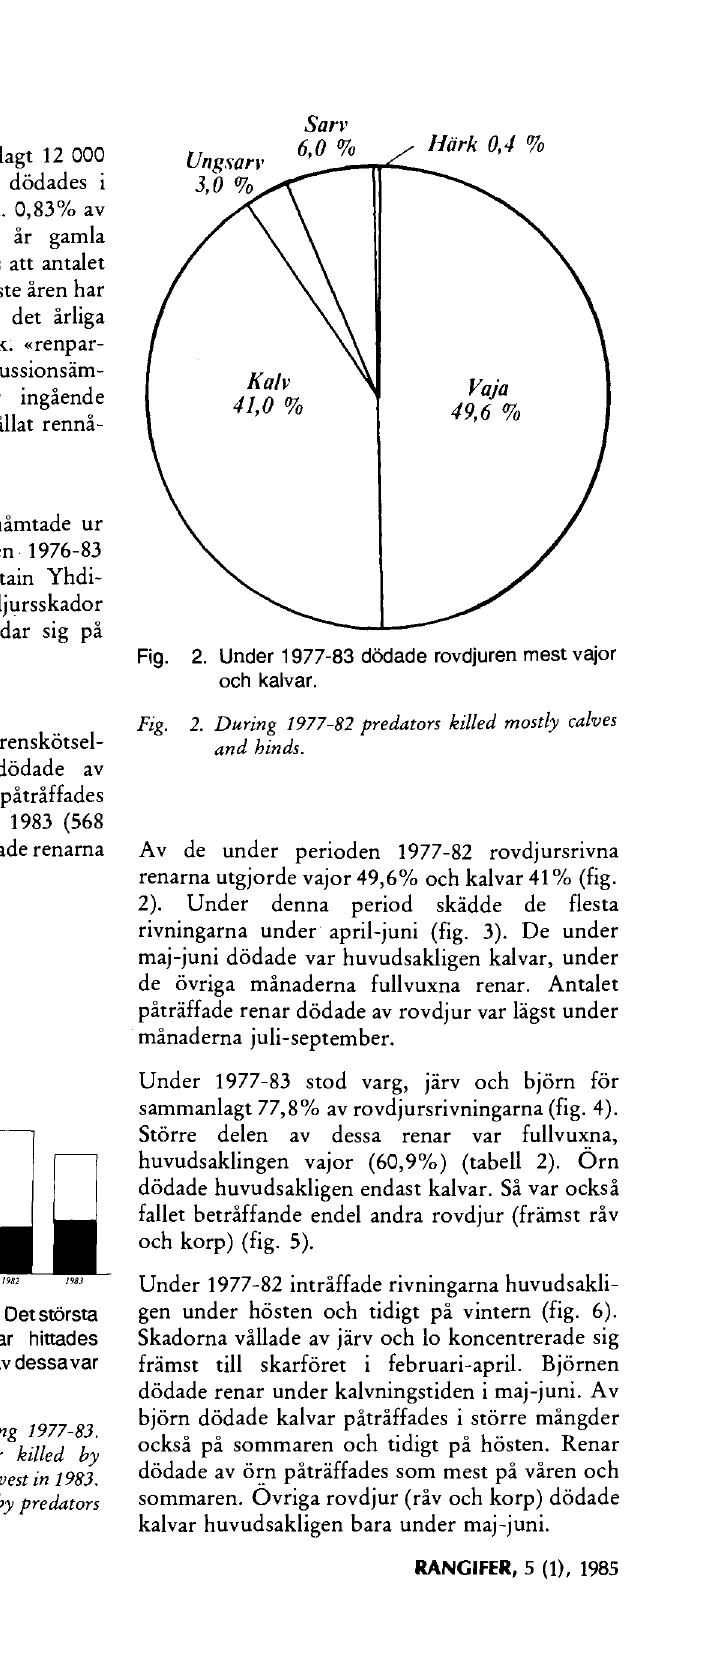
l i l l . .. 1. Av rovdjur dodade renar 1977 - 83. Det storsta